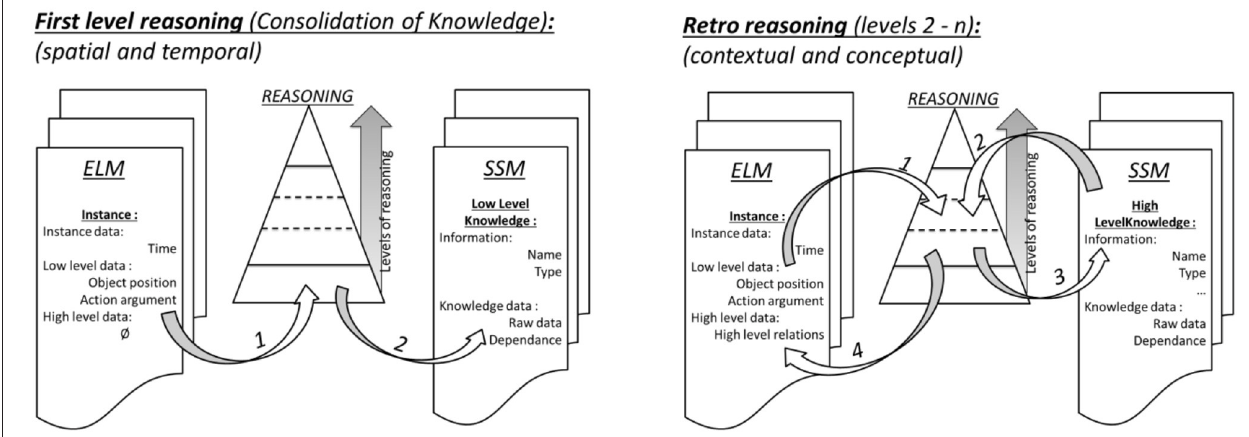
FIGURE 4 | Episodic-Like Memory ELM, Synthetic Semantic Memory SSM. Recursive reasoning for creating knowledge. (Left) First level of reasoning: the iCub retrieves the events in the ELM, and discovers the associated meanings, by using clustering to detect regularities that co-occur with spatial and temporal terms. (Right) 2nd to nth level of reasoning: Retro-reasoning: Once the first level of knowledge has been created, it can be reinjected back into the EML, and the next levels are developed in a loop that will use the previous level of knowledge created as new data, to create the next level of knowledge. From Petit et al.